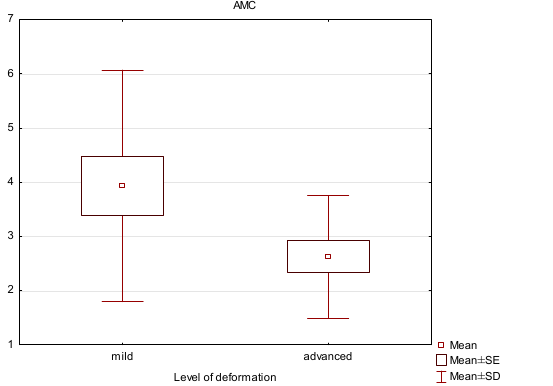
Figure 7. Box and whisker plot of the mineralization index (MI) in patients with mild and advanced deformity in the anterior part of the medial condyle (AMC).